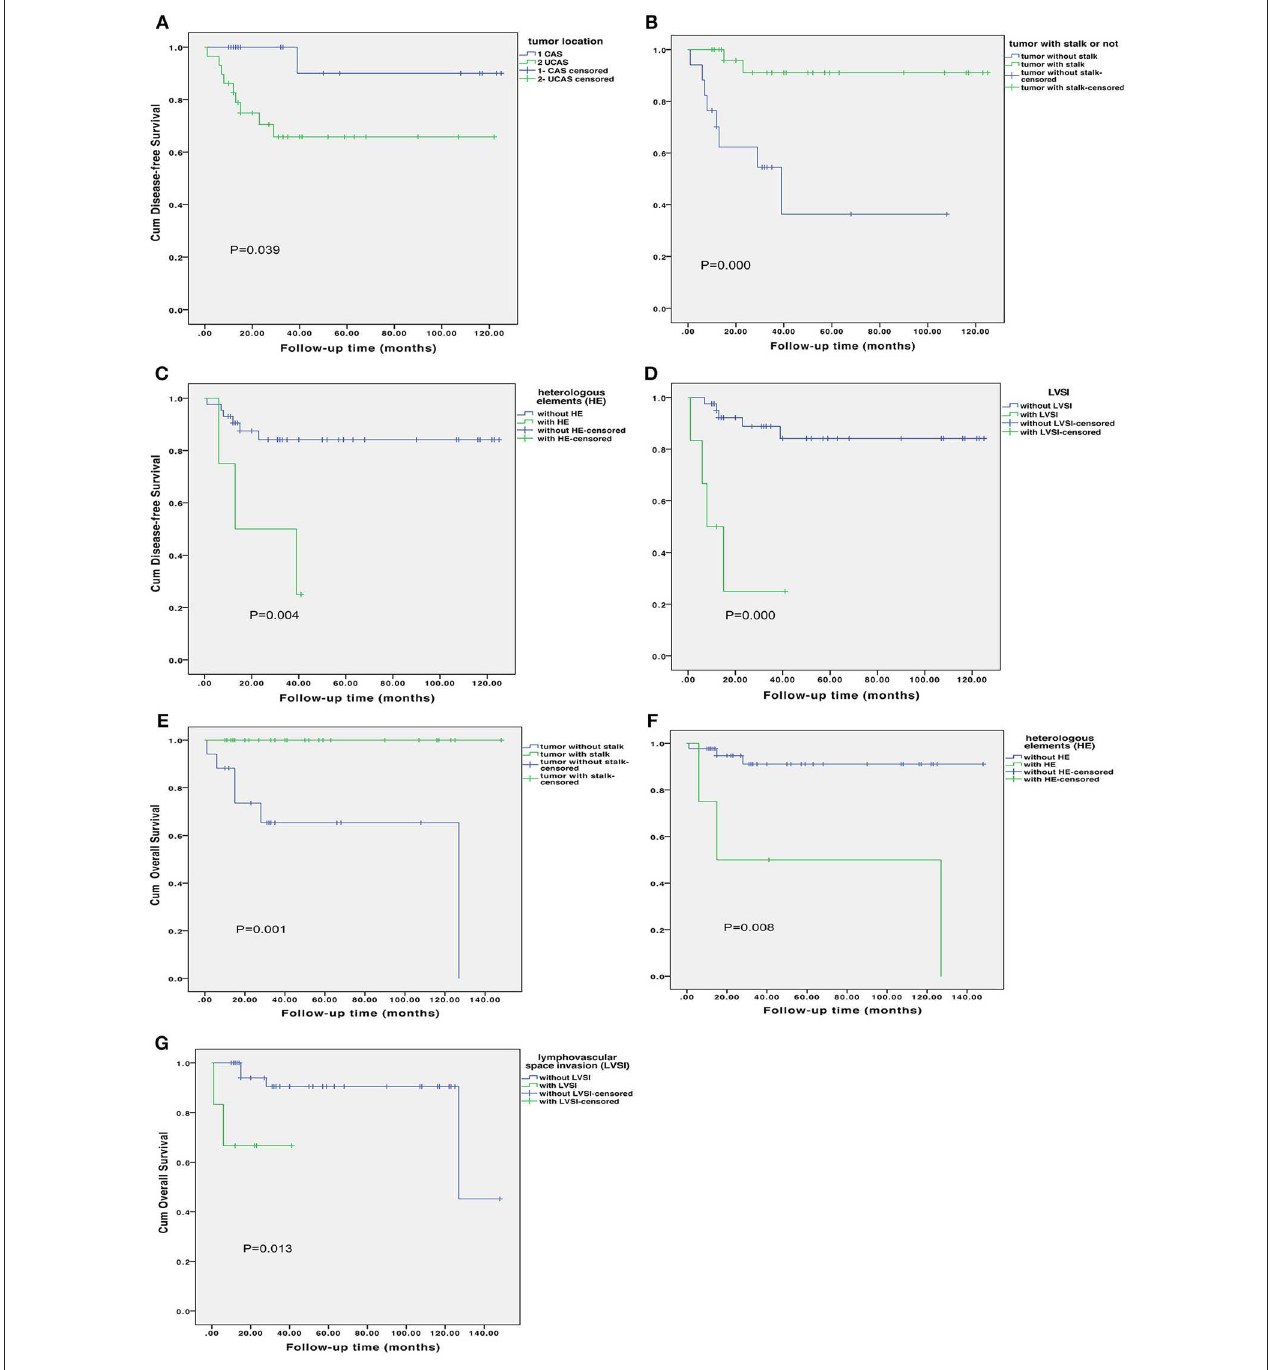
FIGURE 3 | Disease-free survival according to tumor location (A) , presence of tumor stalk (B) , heterologous elements (C) and lymphovascular space invasion [LVSI; (D) ]. Overall survival according to presence of tumor stalk (E) , heterologous elements (F) and lymphovascular space invasion (G) .